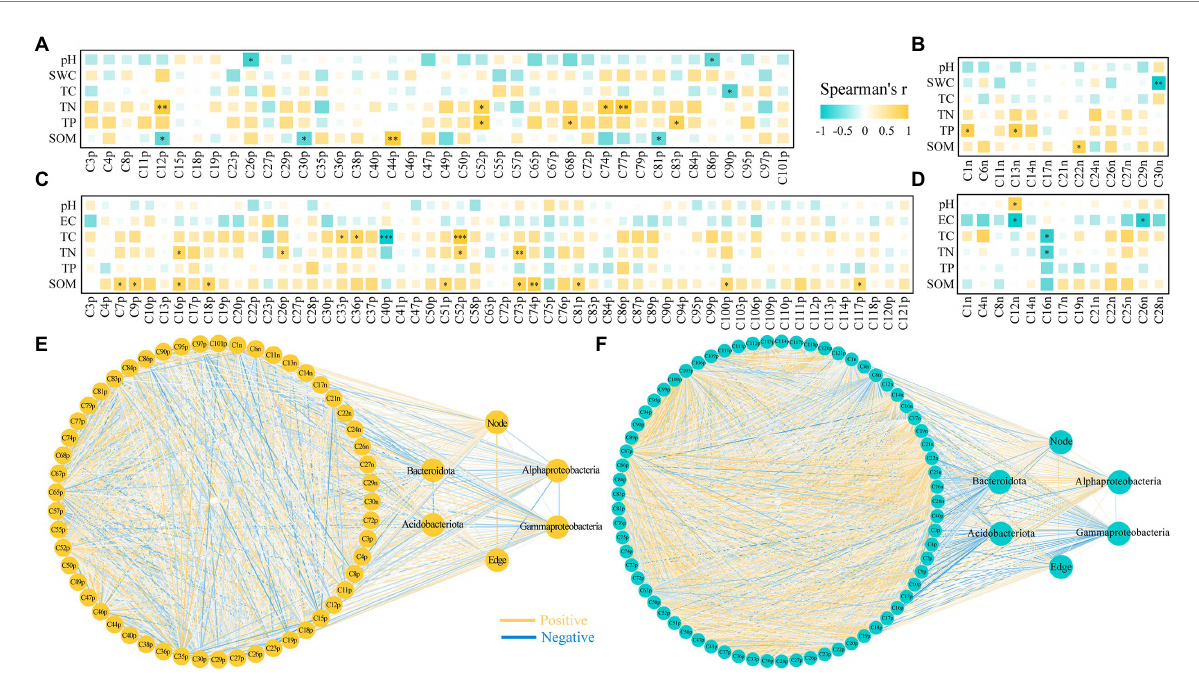
FIGURE 6 Correlation between root exudates and rhizosphere soil properties, bacteria for r-and k-strategists and network properties of Nitraria tangutorum under drought and salt stress. (A) Spearman correlation coefficients between differential metabolites of positive ion mode and rhizosphere soil physicochemical properties under drought stress. (B) Spearman correlation coefficients between differential metabolites of negative ion mode and rhizosphere soil physicochemical properties under drought stress. (C) Spearman correlation coefficients between differential metabolites of positive ion mode and rhizosphere soil physicochemical properties under salt stress. (D) Spearman correlation coefficients between differential metabolites of negative ion mode and rhizosphere soil physicochemical properties under salt stress. Correlation between differential metabolites of positive and negative ion mode, bacteria for r-and k-strategists and network properties of N. tangutorum under drought (E) and salt (F) stress. The significance of factors and the correlations between factors is marked at the figure, where “*” represents p < 0.05, “**” represents p < 0.01, and “***” represents p < 0.001; yellow lines indicate positive correlations whereas blue lines indicate negative correlations. Name of root exudates under drought stress: C50p: 6-Methylquinoline; C68p: TKK; C3p: Proline; C38p: Creatine; C67p: 8-Hydroxyquinoline; C86p: Panthenol; C19p: Indole-3- acetic acid; C95p: D-(+)-Maltose; C29p: 5-(2,5-dihydroxyhexyl)oxolan-2-one; C27p: Prolylglycine; C4p: Choline; C90p: 2-methyl-2,3,4,5- tetrahydro-1,5-benzoxazepin-4-one; C18p: Acetyl-L-carnitine; C15p: L-Methionine sulfoxide; C26p: Indole-3-acrylic acid;